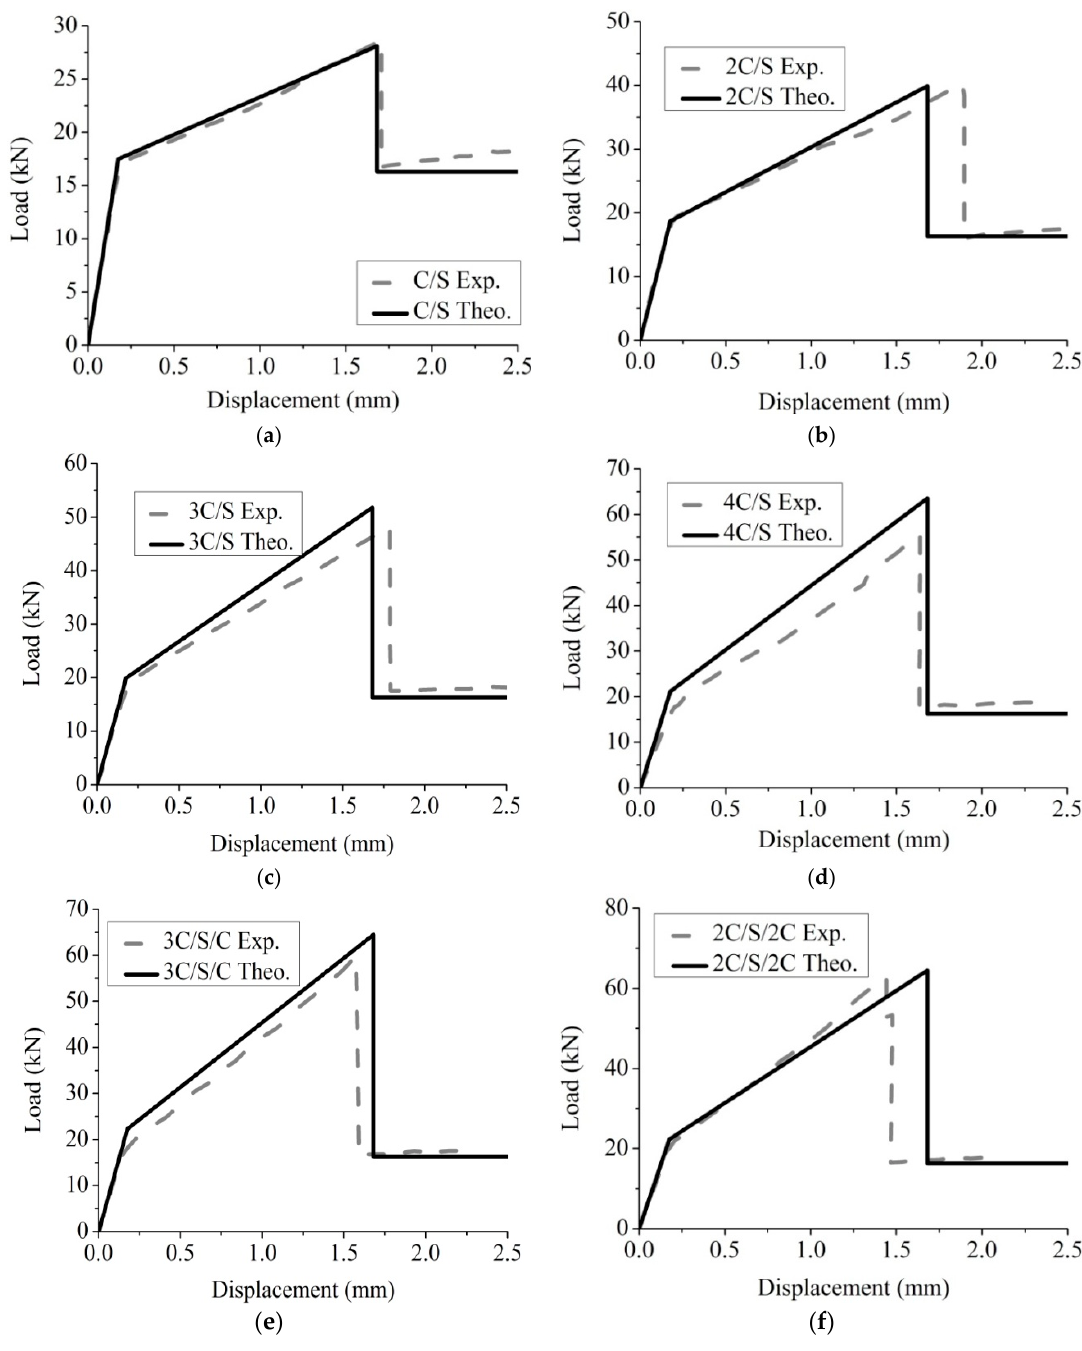
Figure 10. Load-displacement curves of series L and S specimens ( a ) C/S; ( b ) 2C/S; ( c ) 3C/S; ( d ) 4C/S; ( e ) 3C/S/C; and ( f ) 2C/S/2C.